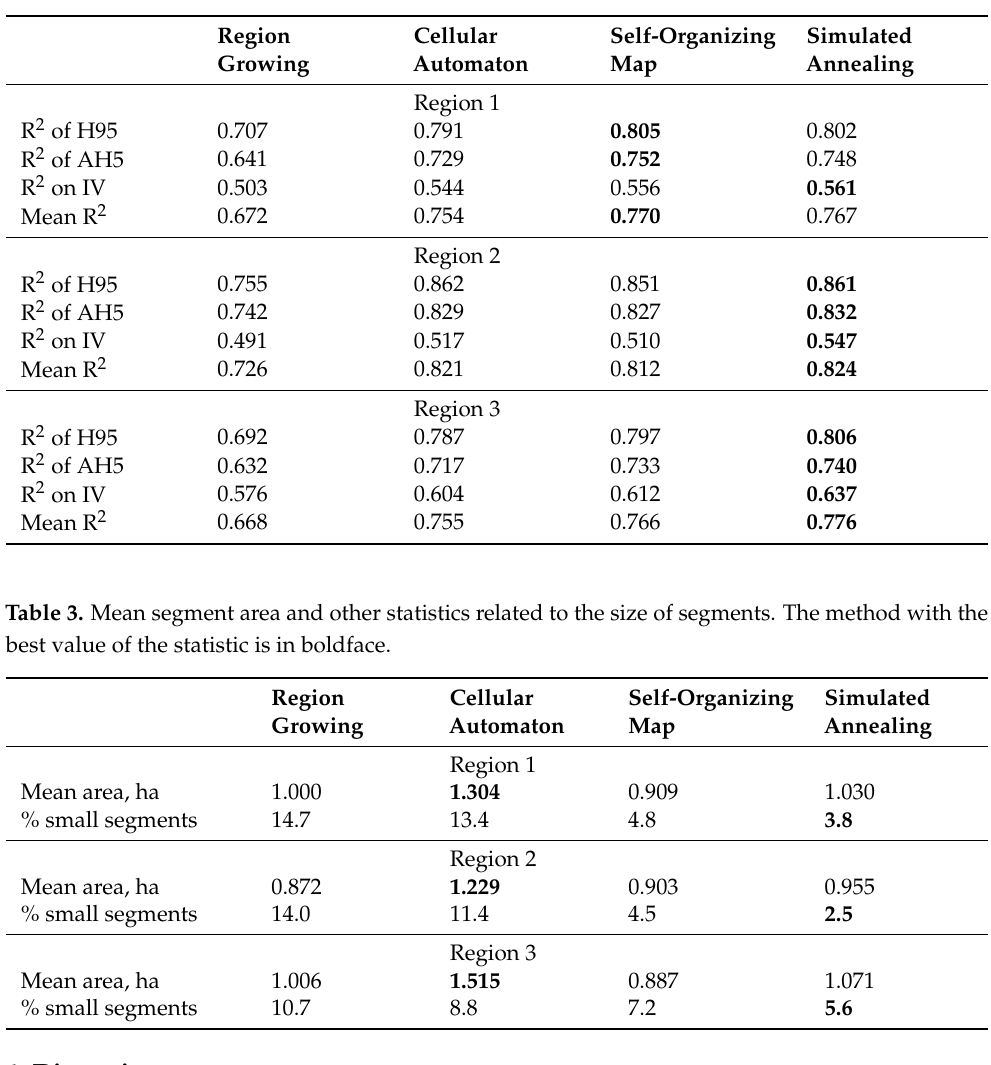
Table 2. Proportion of variance explained by the segmentation. The method with the highest (best) R 2 is in boldface.